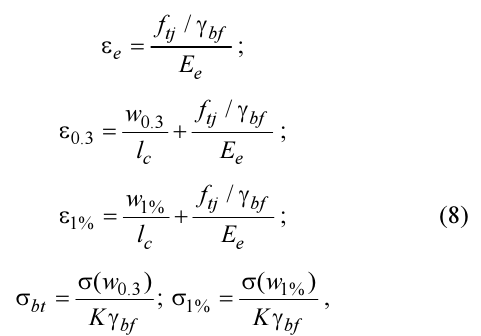
Fig. 2. Stress-strain when tensile stress is applied (AFGC-SETRA 2002)